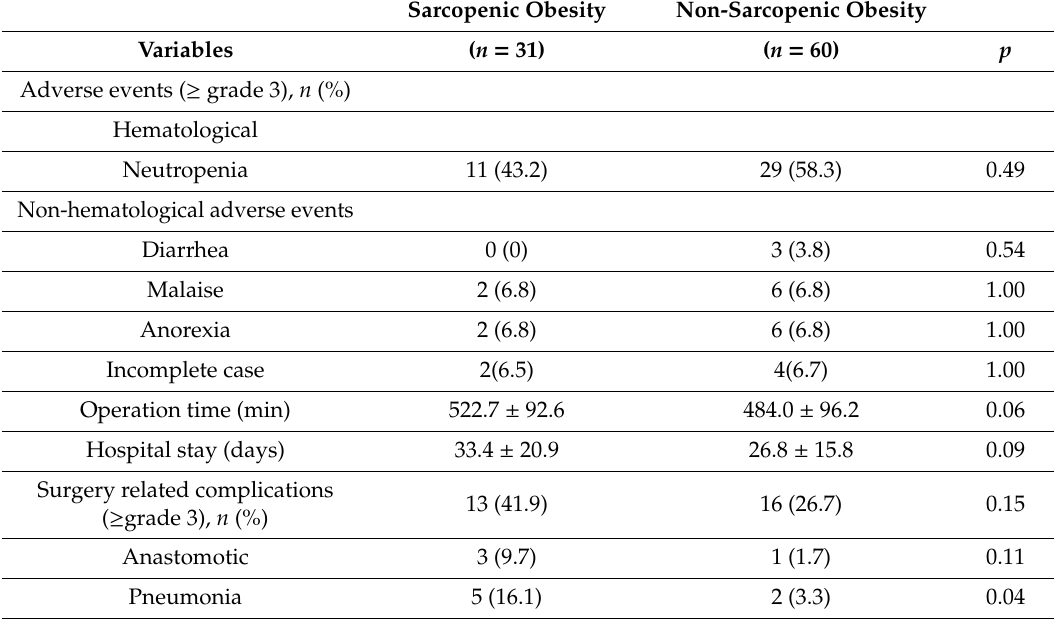
Table 5. Treatment-related factors in elderly patients with and without sarcopenic